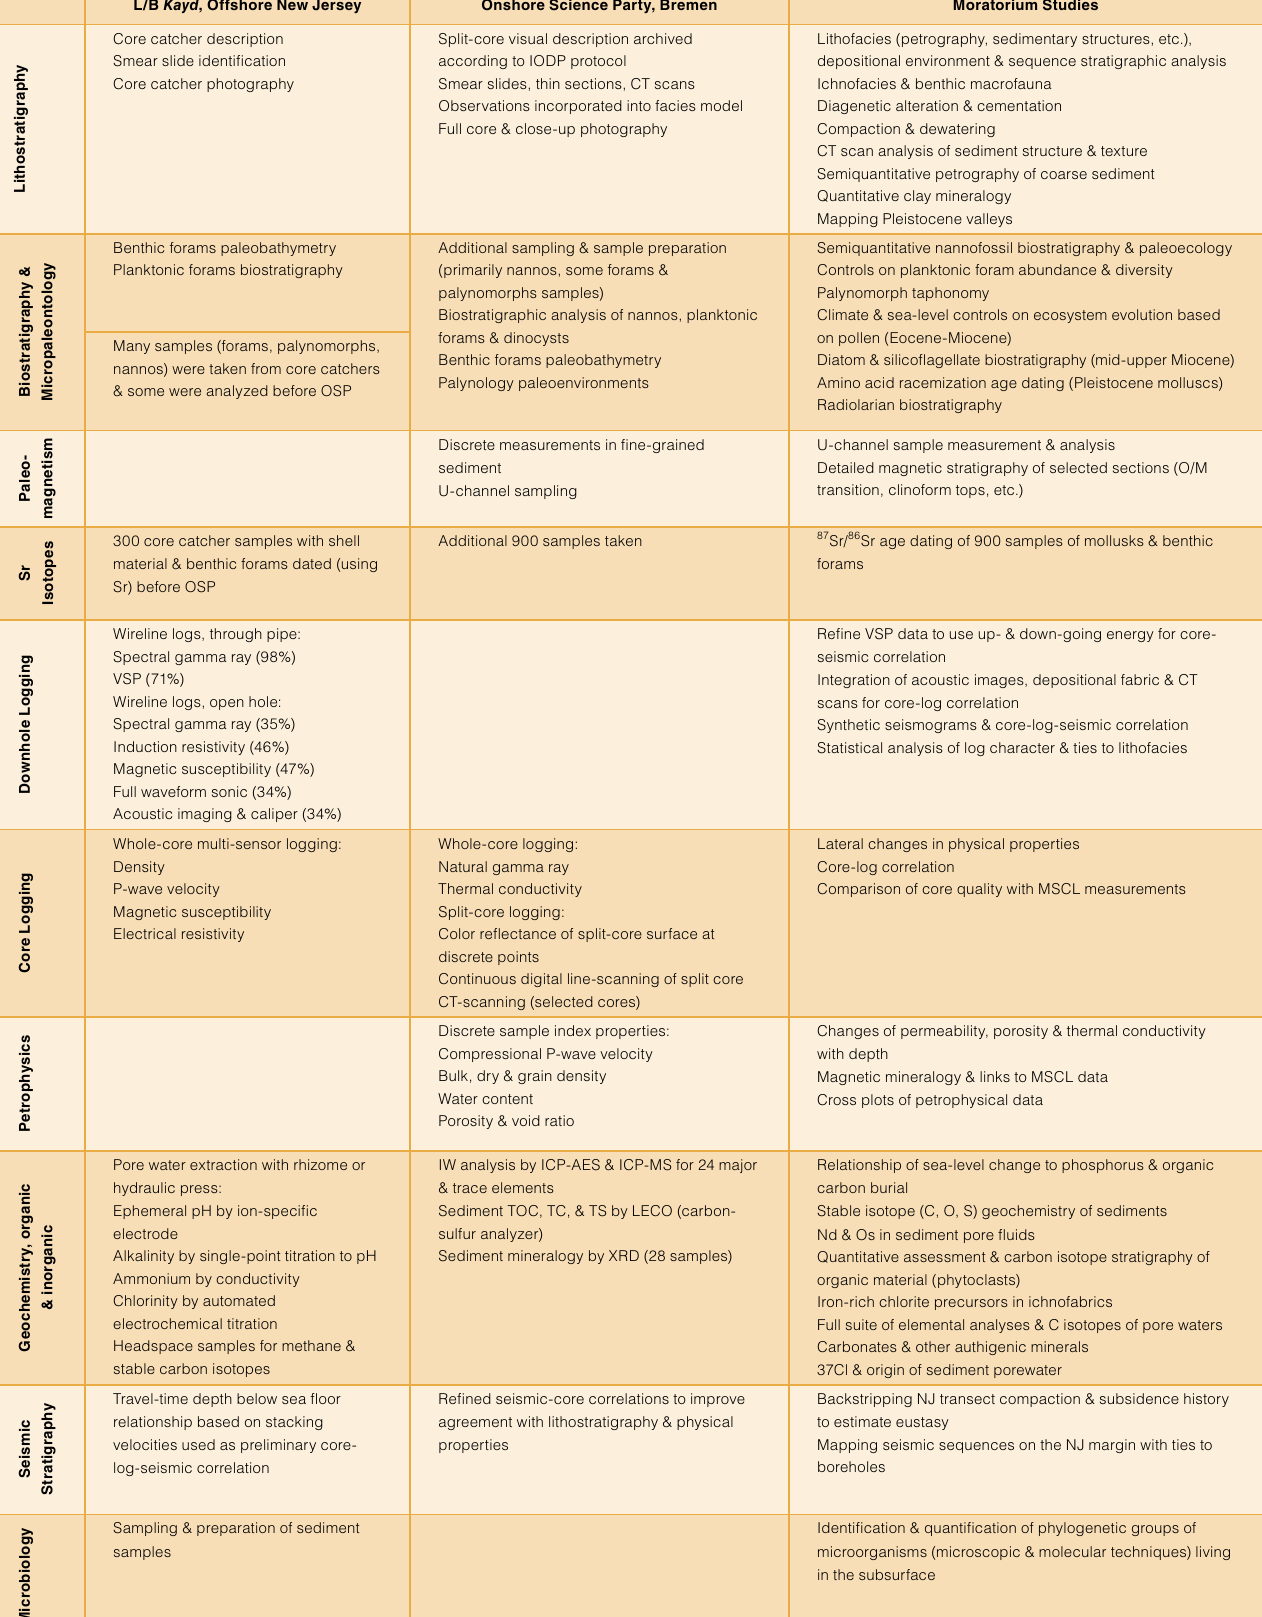
Table 2. Expedition 313 Measurements